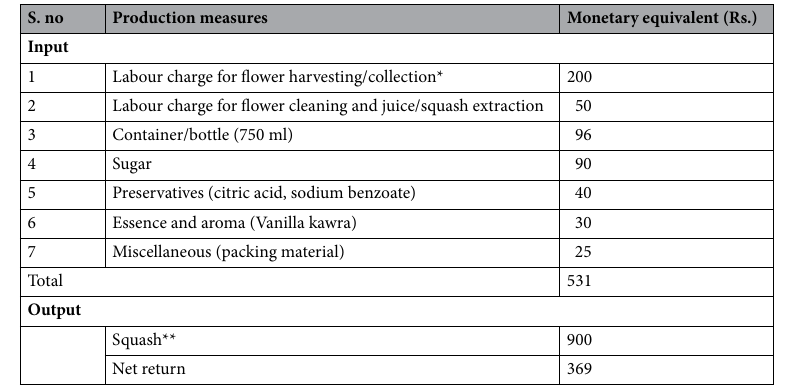
Table 6. Cost–benefit analysis (Rs./per day) of Juice/squash prepared from R. arboreum flower in Garhwal region. *Two bottles (750 ml) of pure juice is obtained from one kg of fresh flowers and one person (male/